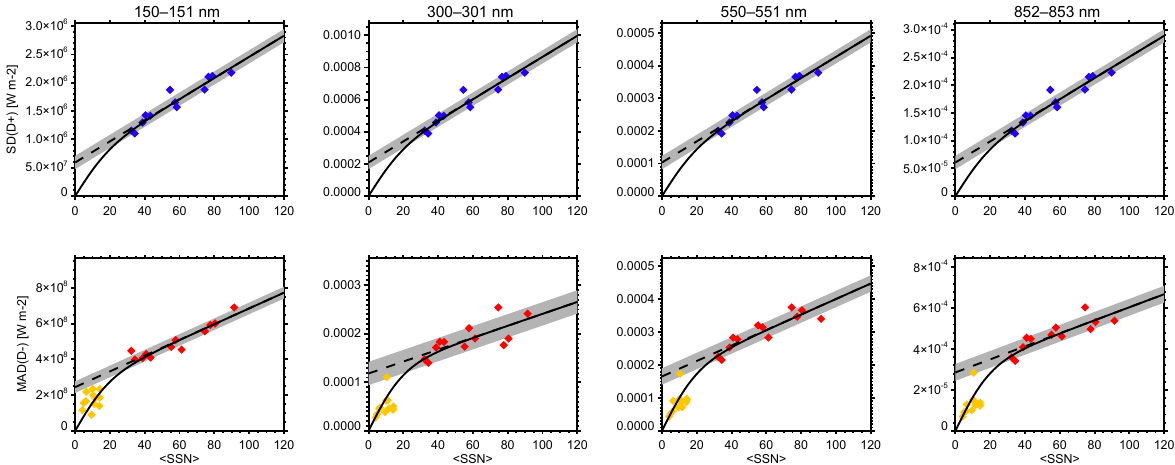
Figure H3. Regression of SD(D + ) SC (top, blue symbols) and MAD(D − ) SC (bottom, red symbols) to < SSN > at wavelength bins centered at 150.5, 300.5, 550.5, and 852.5nm (from left to right). The resulting linear fit is shown by dashed black lines; the grey shaded areas reflect the RMS errors. The solid black lines show the functional dependence used in the scaling after application of a nonlinear correction for low < SSN > values. MAD(D − ) values calculated from the low-activity part of the solar cycles provide an estimate for very weak solar cycles and are shown with orange symbols (only lower panels).